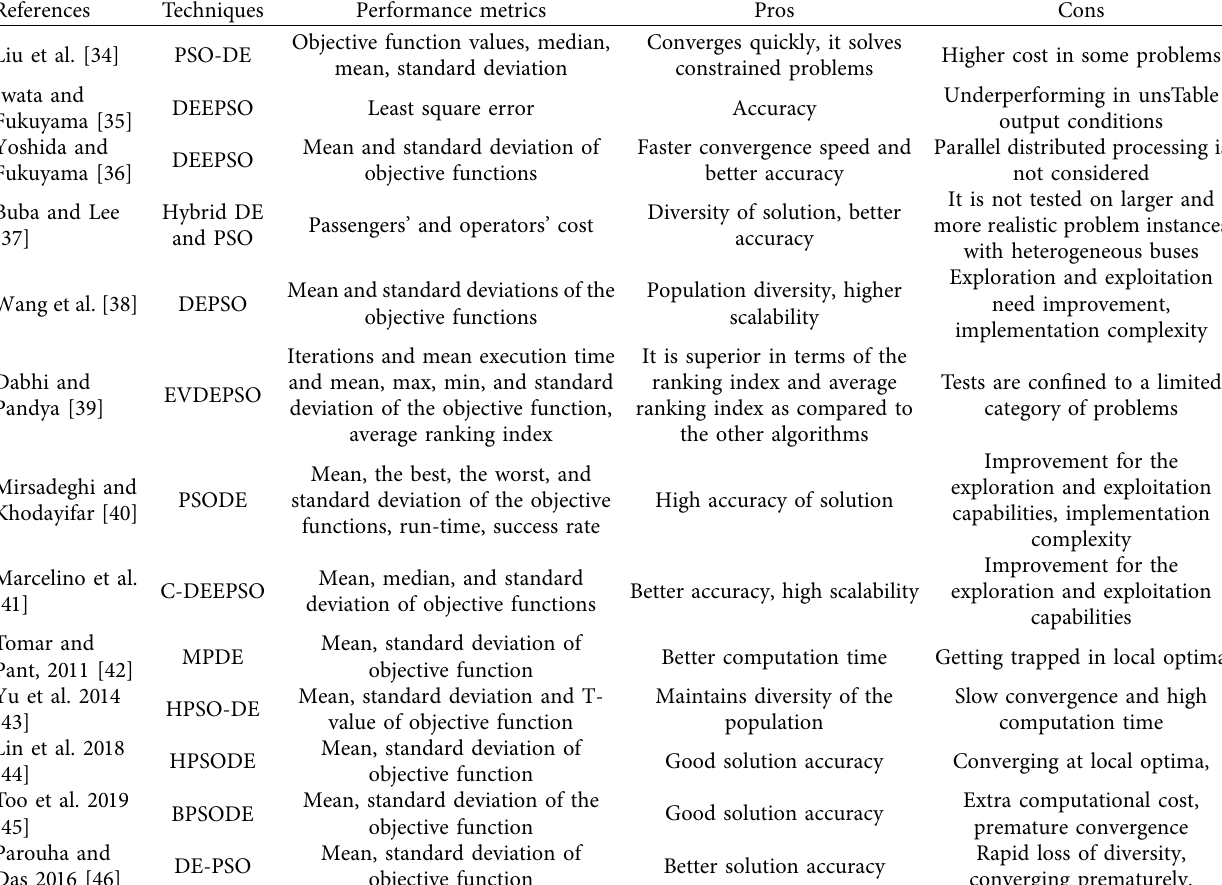
Table 2: Summary of existing works on hybrid particle swarm optimization